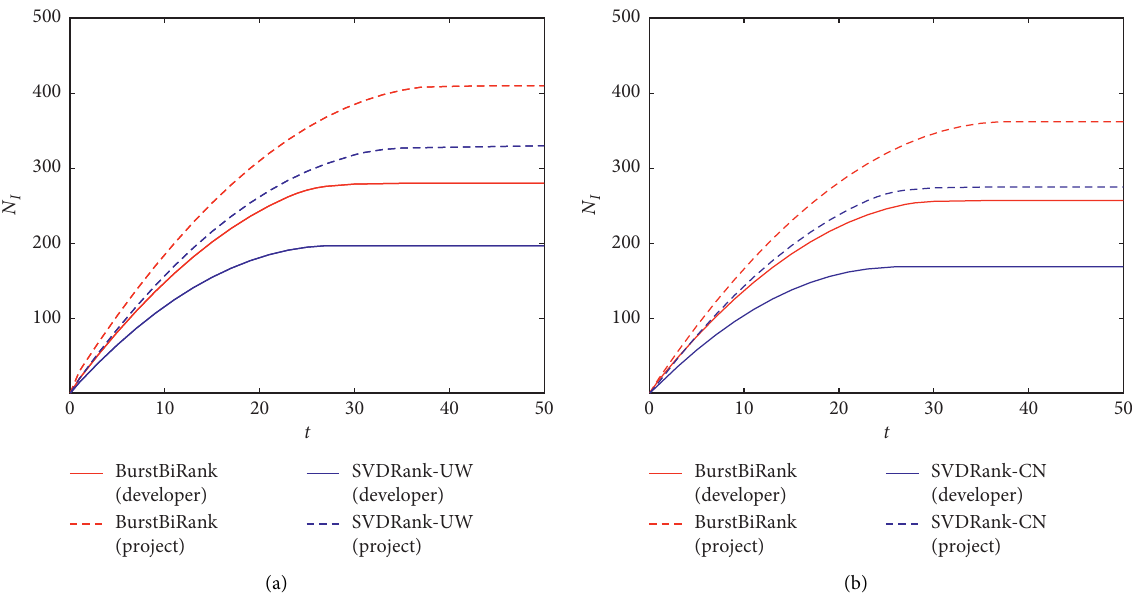
Figure 6: Performance comparison between BurstBiRank and SVDRank. (a) BurstBiRank vs. SVDRank-UW. (b) BurstBiRank vs. SVDRank-CN.